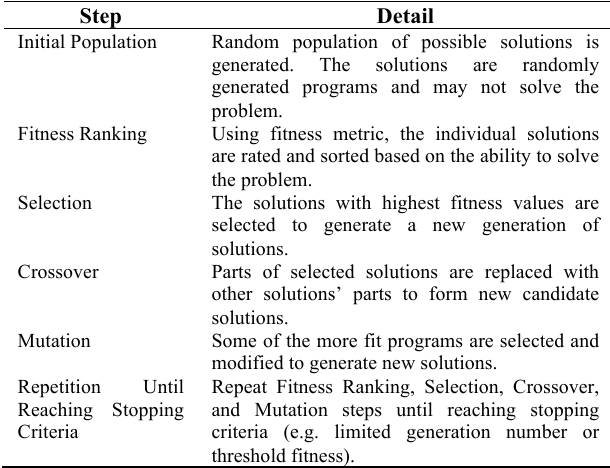
Figure 1. Example of candidate solution represented as hierarchical tree expression (internally) and computer program